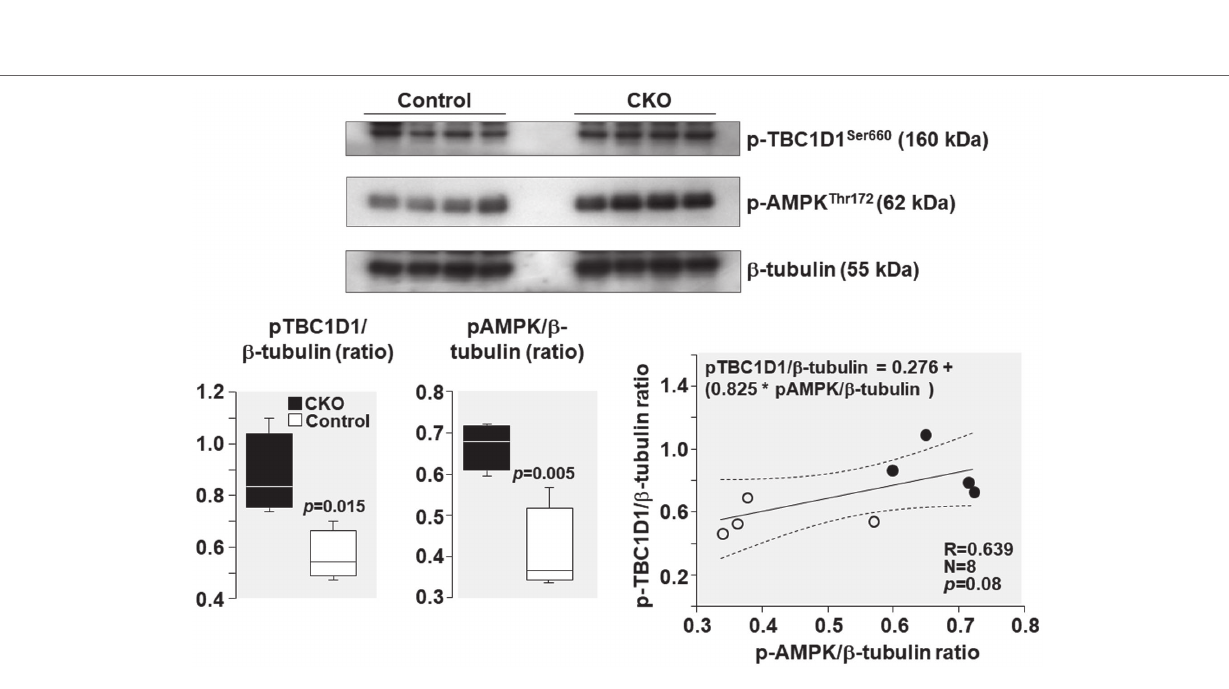
FIGURE 5 | Western blots demonstrating levels of AMPK phosphorylation at threonine 172 (Thr172), TBC1D1 phosphorylation at serine 660 (Ser 660), and β -tubulin (loading control) in mice skeletal muscles after exercise. Box plots denote densitometry of pAMPK and pTBC1D1 normalized to β -tubulin. N = 4 from each group. Relationship between pAMPK/ β -tubulin ratio and pTBC1D1/ β -tubulin ratio is shown. The regression line is shown with the corresponding 95% confidence